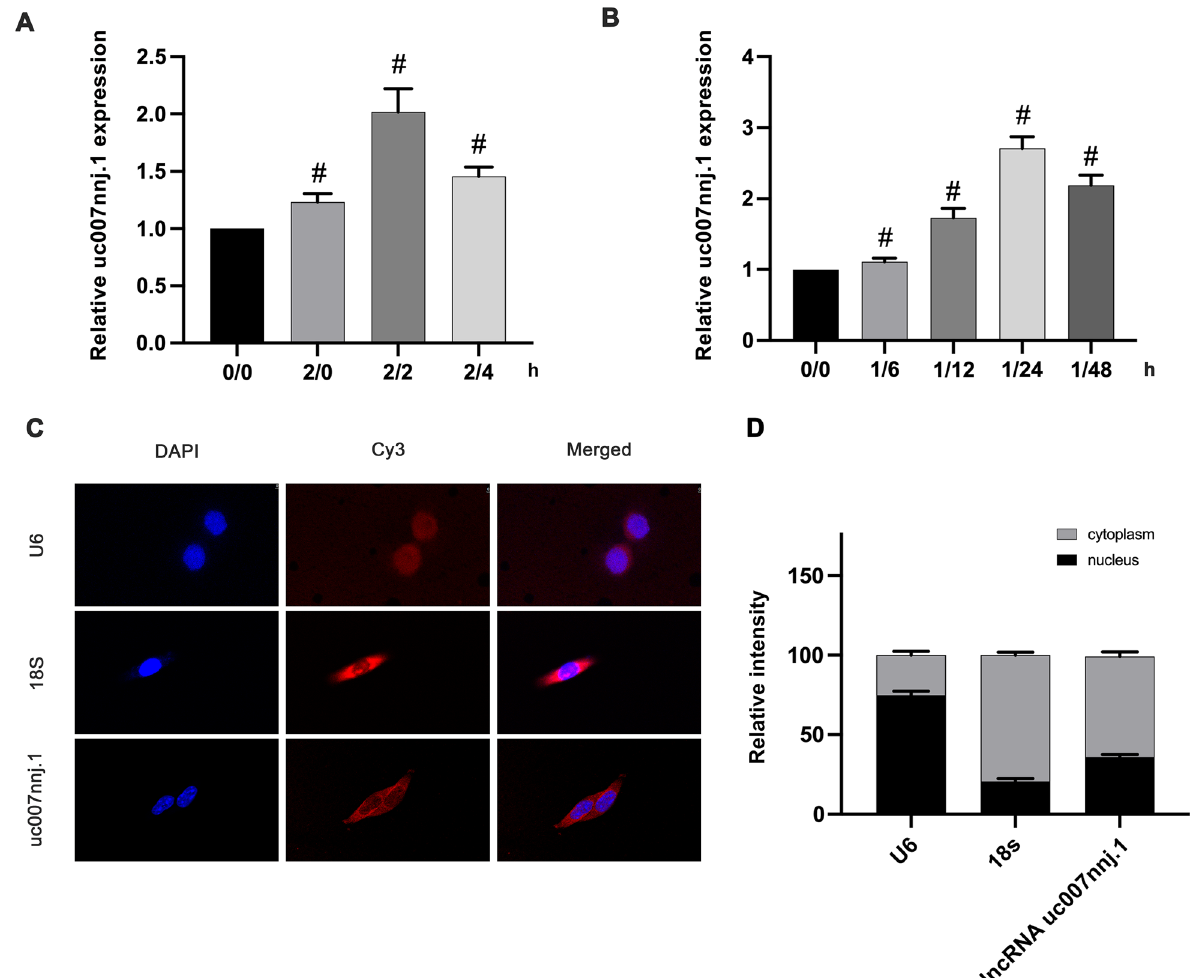
Fig. 1 Ischemia–reperfusion injury induced lncRNA uc007nnj.1 expression of in vivo and in vitro. Cultured primary mouse RGCs were treated with or without Ca 2 + (2µM) and antimycin (10 µM) in HBSS (ATP and glucose depletion) at indicated time periods (ischemia/reperfusion for 0/0 h, 2/0 h, 2/2 h, and 2/4 h, respectively). Reverse transcription-quantitative real-time PCR (RT-qPCR) analysis was used to detect the expression of lncRNA uc007nnj.1. B The intraocular pressure was elevated to 120 mmHg for 1 h to induce transient retinal ischemia and then exposed to reperfusion for 6, 12, 24, and 48 h in C57BL/6J mice. The expression levels of lncRNA uc007nnj.1 in the retinas were detected by RT-qPCR. C Representative FISH images of the location of lncRNA uc007nnj.1 (red) in RGCs. U6 and 18 s were used as nuclear and cytoplasmic markers, respectively. Scale bar: 10 µm. D Relative intensity analysis of FISH images. Data are expressed as mean SD of six independent experiments; # p < 0.05 versus 0/0 h or sham ±